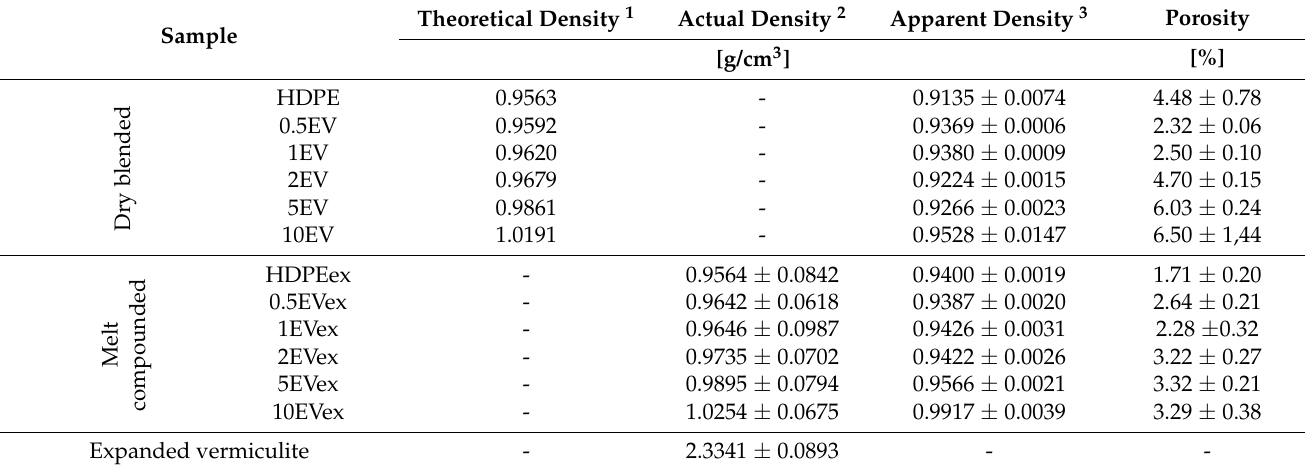
Table 2. The densities of materials used to prepare rotomolded samples and porosity in rotomolded samples. Sample